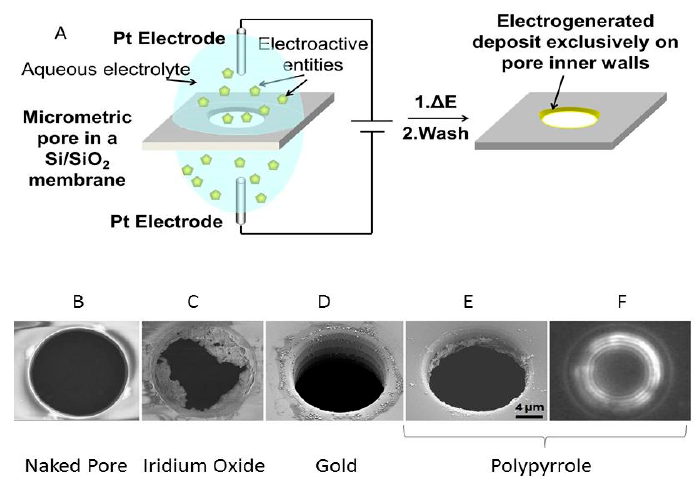
Figure 1. Implementation of contactless electro-functionalization (CLEF). ( A ) Principle of the specific functionalization of the inner wall of the pore. SEM characterizations of ( B ) naked pore, ( C ) iridium oxide deposit, ( D ) gold deposit, ( E ) oligonucleotide-functionalized polypyrrole (PPy-ODN) deposit also revealed using fluorescence microscopy ( F ).